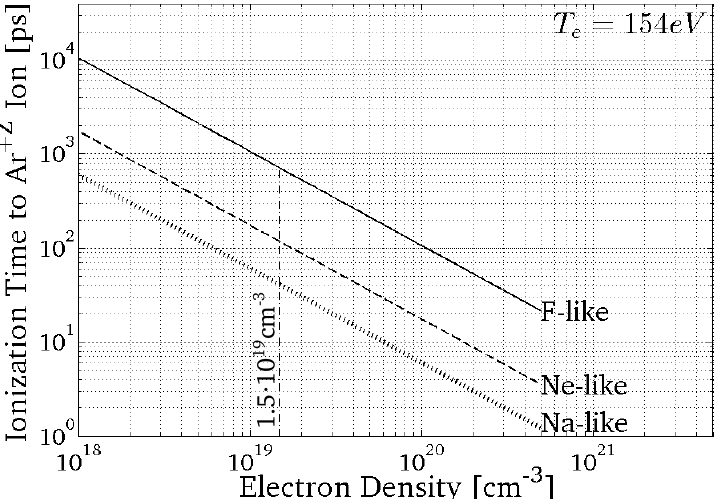
Figure 4. Ionization time to achieve the Ar + Z ion as a function of the electron density at the optimum electron temperature for the following: (i) Ar +6 → Ar +7 (Na-like); (ii) Ar +7 → Ar +8 (Ne-like); and (iii) Ar +8 → Ar +9 (F-like).